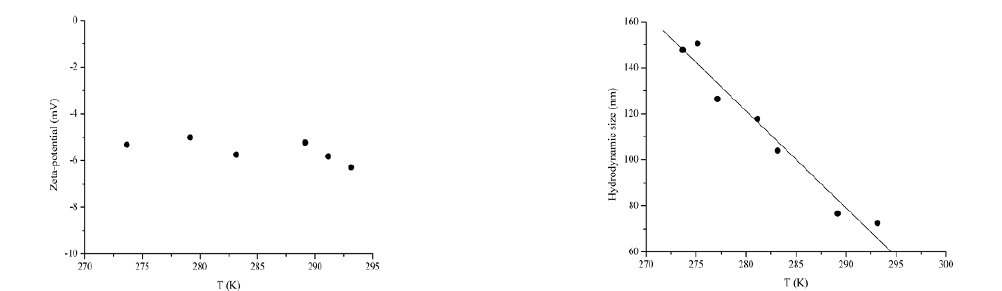
Figure 2. Zeta-potentials (left) and hydrodynamic sizes of ZnS colloidal dispersions as a function of thermodynamic